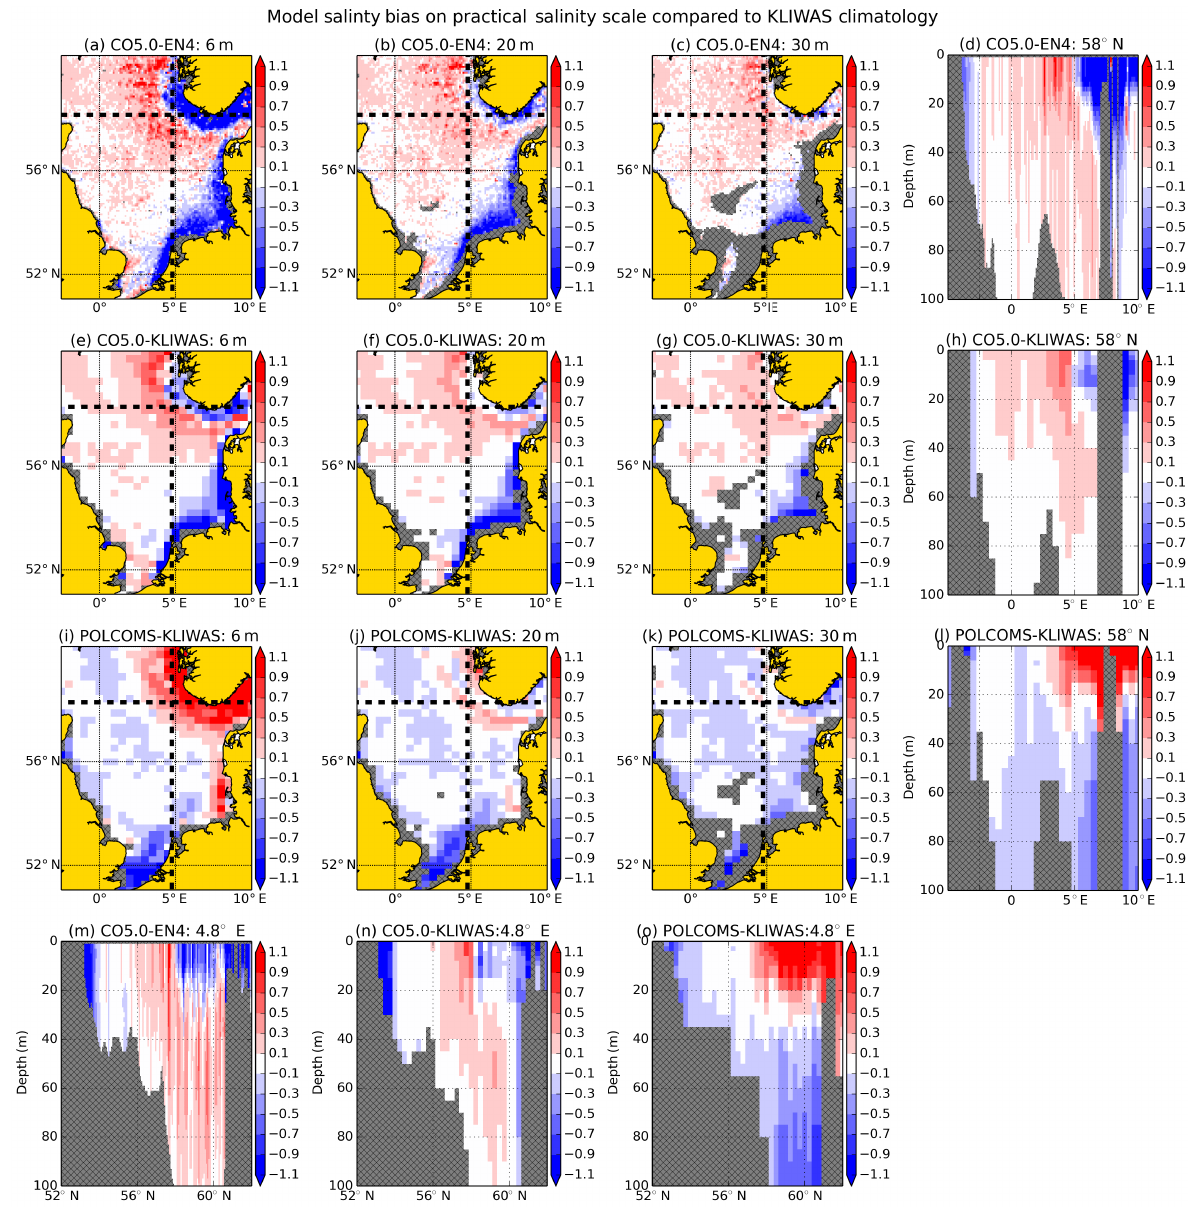
Figure 11. North Sea salinity bias compared to annual EN4 and KLIWAS climatology. Panels (a) – (d) compare CO5 and EN4 at 6, 20 and 30m and along a transect at 58 ◦ N. Panels (e) – (h) compare CO5 and KLIWAS climatology at 6, 20 and 30m and along a transect at 58 ◦ N. Panels (e) – (h) compare POLCOMS and KLIWAS climatology at 6, 20 and 30m and along a transect at 58 ◦ N. Panels (m) – (o) are transects through depth for each case along longitude 4.8 ◦